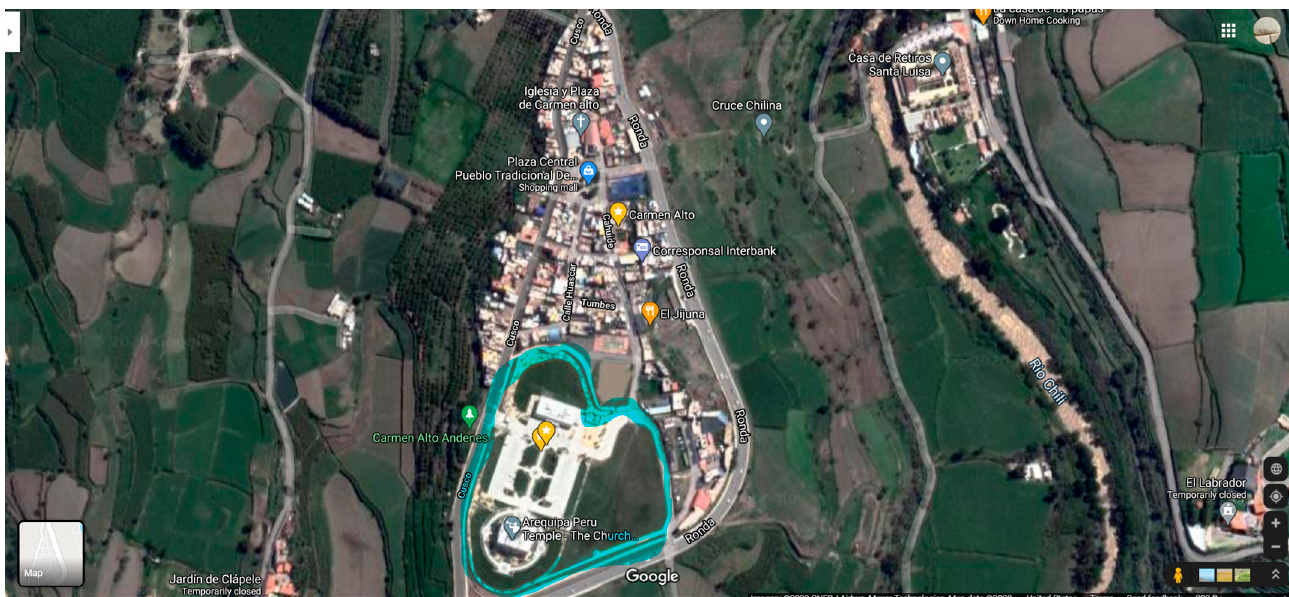
Figure 10. Though the Mormons only used thirty percent of their new property for the temple proper, the property itself, highlighted in blue in this Google Maps satellite image, occupies a whopping thirty-six percent of Carmen Alto, a town that previously had no Mormon presence whatsoever. Screenshot, August 2020.